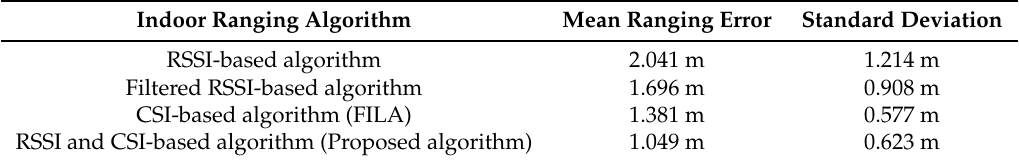
Table 3. Comparison of four indoor ranging algorithms (IT-1 building).